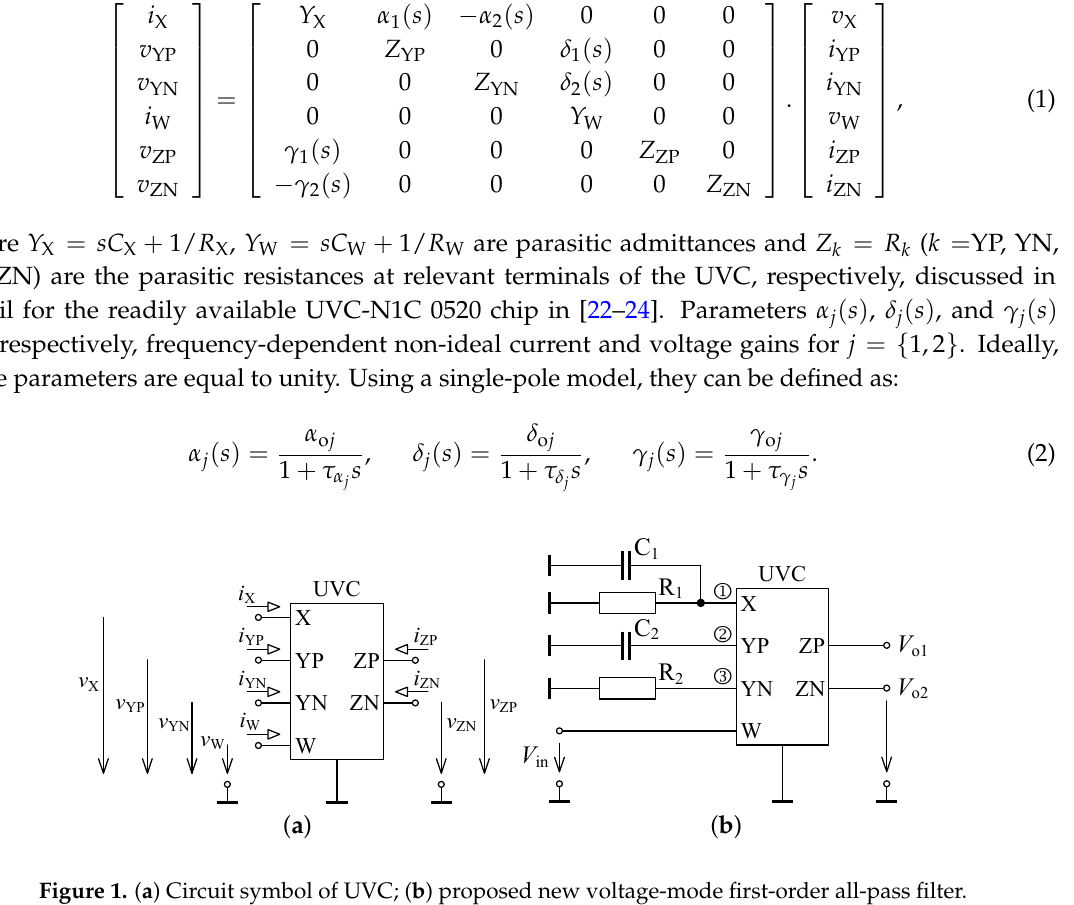
Figure 1. ( a ) Circuit symbol of UVC; ( b ) proposed new voltage-mode first-order all-pass